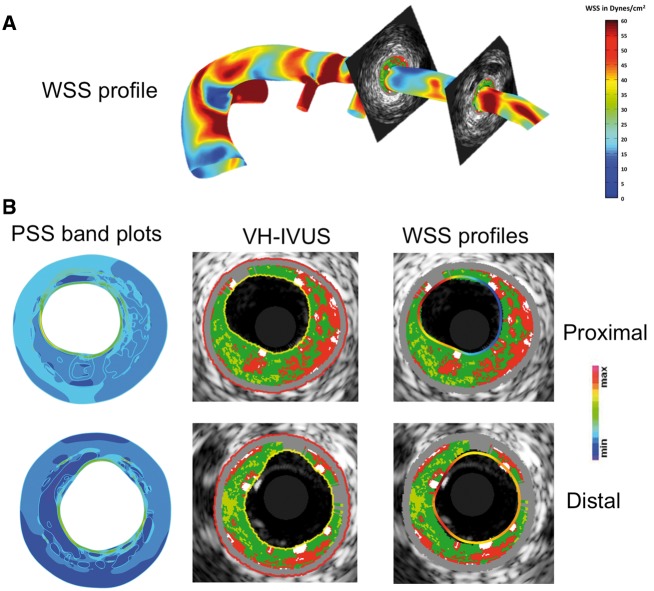
Examples of wall shear stress and plaque structural stress calculations. (A) Wall shear stress profile of a left anterior descending artery with (B) examples of plaque structural stress band plots (left) from individual virtual-histology intravascular ultrasound frames (middle) and virtual-histology intravascular ultrasound frames with superimposed wall shear stress contours (right) at proximal and distal frames shown in (A). PSS, plaque structural stress; VH-IVUS, virtual-histology intravascular ultrasound; WSS, wall shear stress.